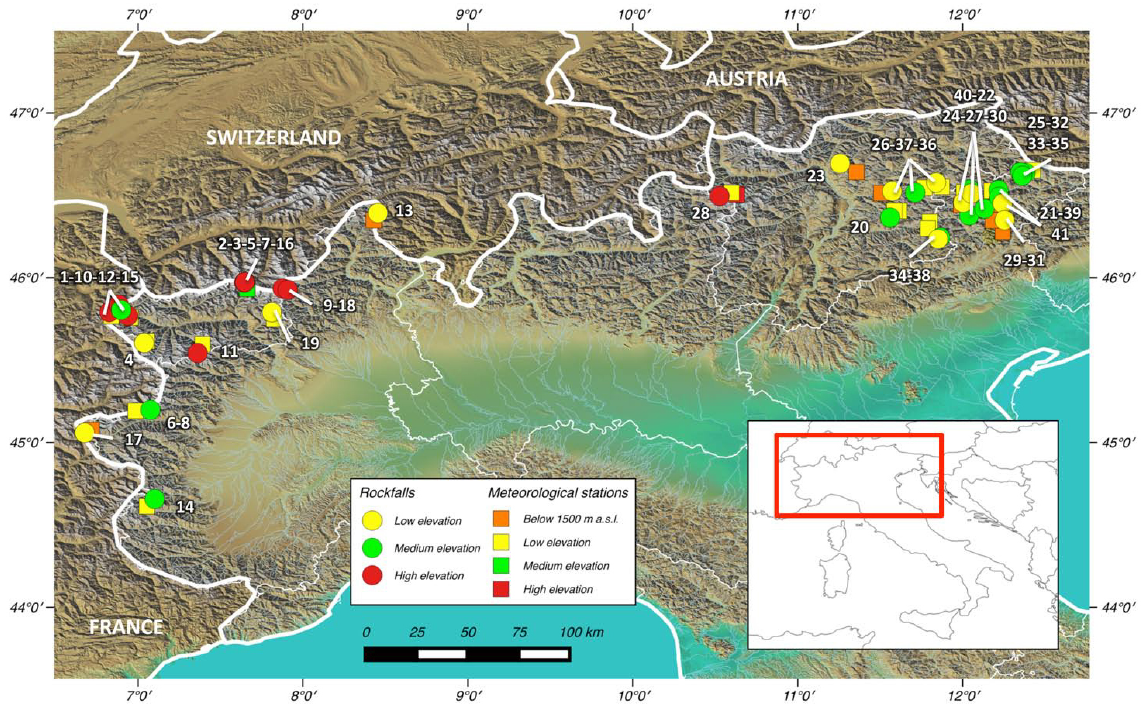
Figure 1. Map showing 41 events included in the inventory (dots) and of the 27 meteorological stations used in the study (squares). Events and meteorological stations are coloured differently according to elevation. Yellow dots/squares represent events/meteorological stations at low elevation (1500–2400ma.s.l.); green dots/squares represent events/meteorological stations at medium elevation (2400–3300ma.s.l.); red dots/squares represent events/meteorological stations at high elevation (3300–4200ma.s.l.); meteorological stations located below 1500ma.s.l. are in orange. Events are numbered according to Table